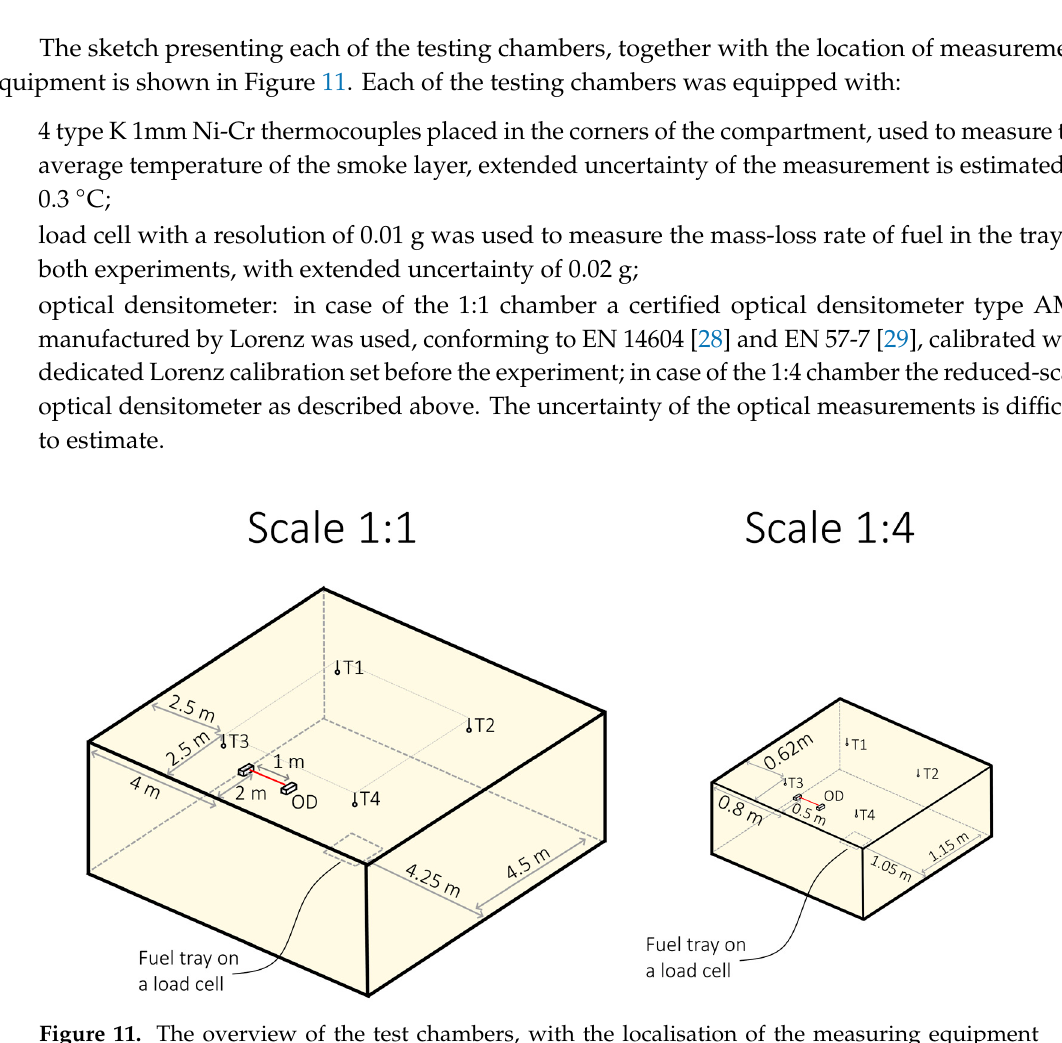
Figure 11. The overview of the test chambers, with the localisation of the measuring equipment (OD—optical densitometer, T1–T4—four thermocouples that were placed symmetrically in four of the corners of the compartment).